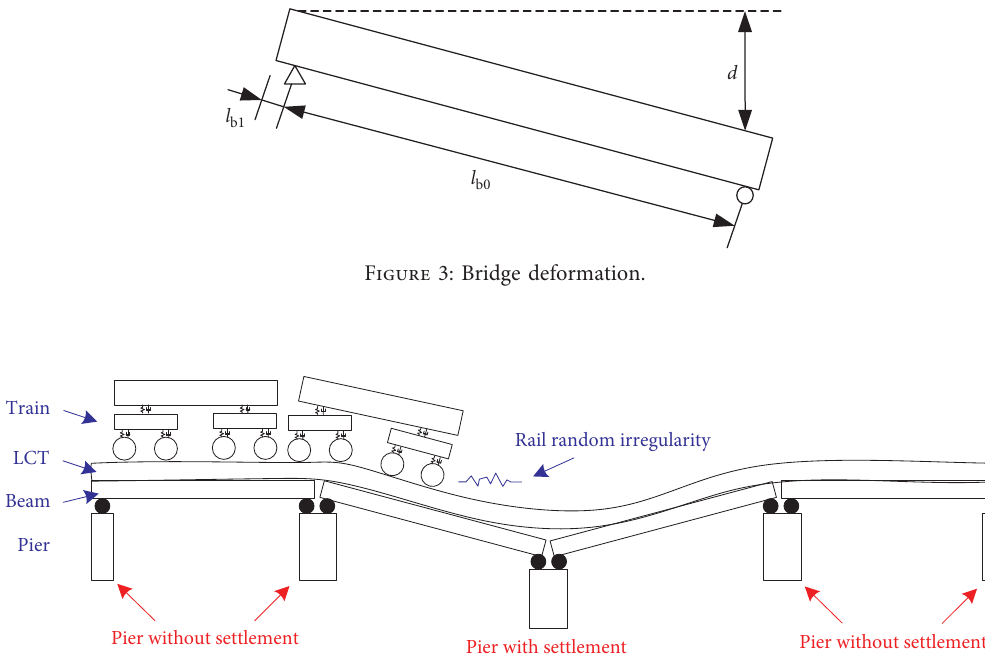
Figure 4: Dynamic model of the high-speed train-LCT-bridge